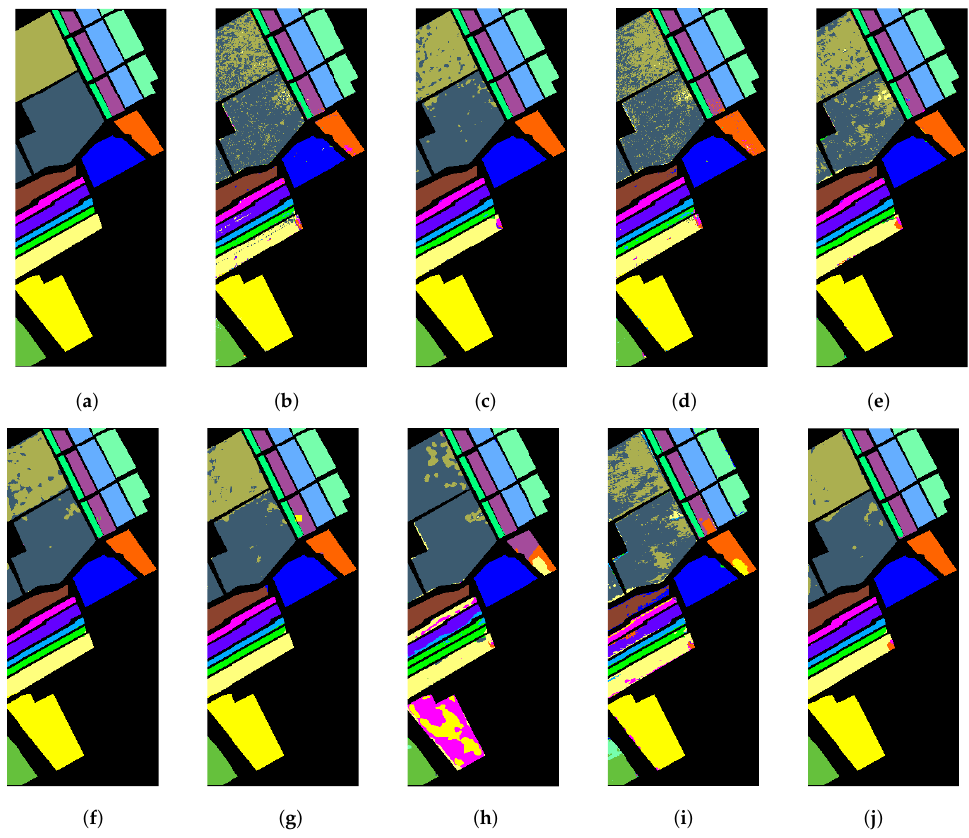
Figure 9. Classification results of ground truth and comparison methods for the SV